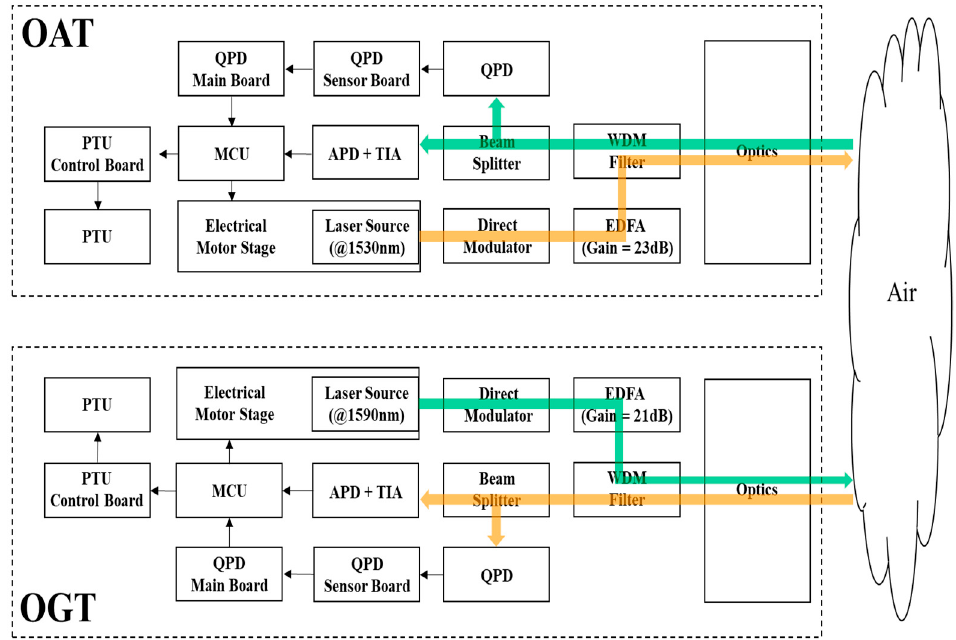
Figure 2. FSO communication system between OGT and OAT.